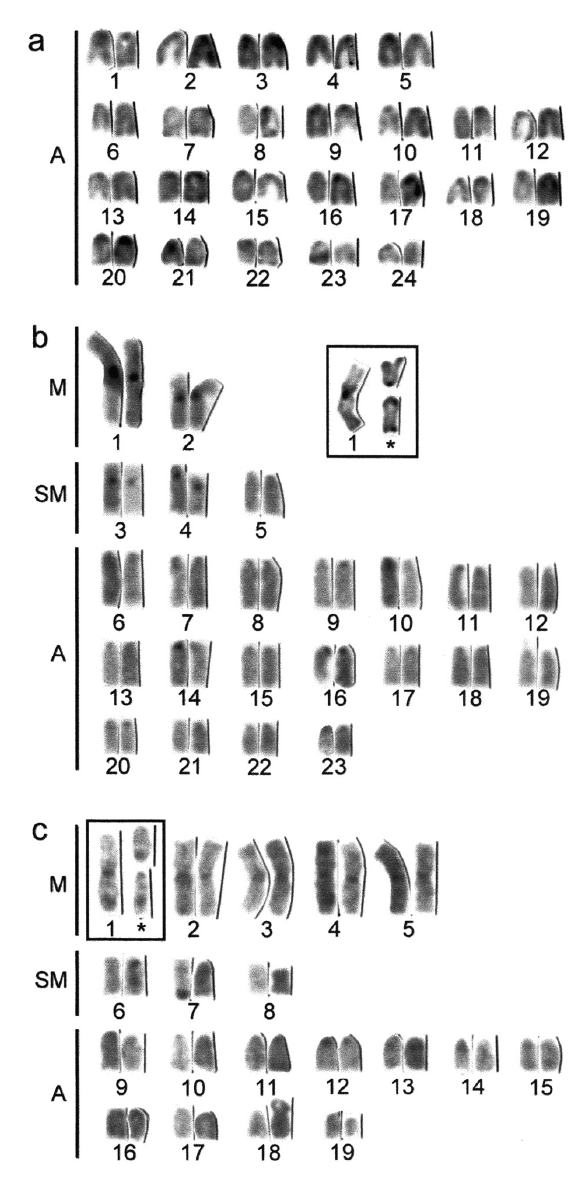
Figure 2 - C-banded karyotypes of Chromis multilineata (a), C. insolata (b) and C. flavicauda (c) with chromosomes related to centric fusion indi- cated in the